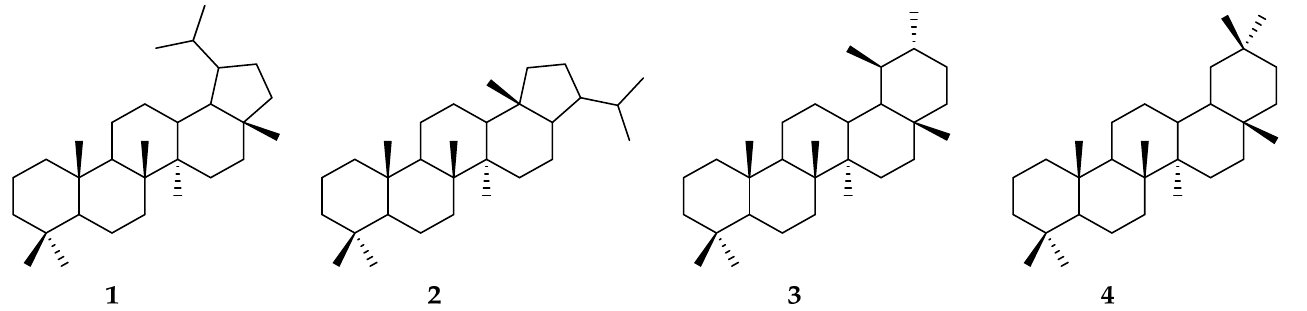
Figure 1. Examples of structural families of triterpenes—lupane ( 1 ), hopane ( 2 ), ursane ( 3 ), and oleanane ( 4 ). Triterpenes often have a variety of biological activities, and among them, betulinic acid ( 5 ) plays an important role, along with ursolic ( 6 ) and oleanolic acid ( 7 ) (Figure 2) [19–27].